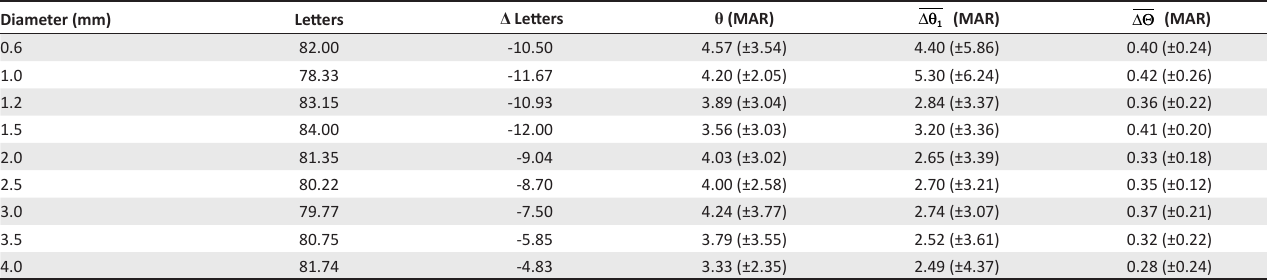
TABLE 4: Mean values for improved scotopic conservative conditions. Diameter (mm)